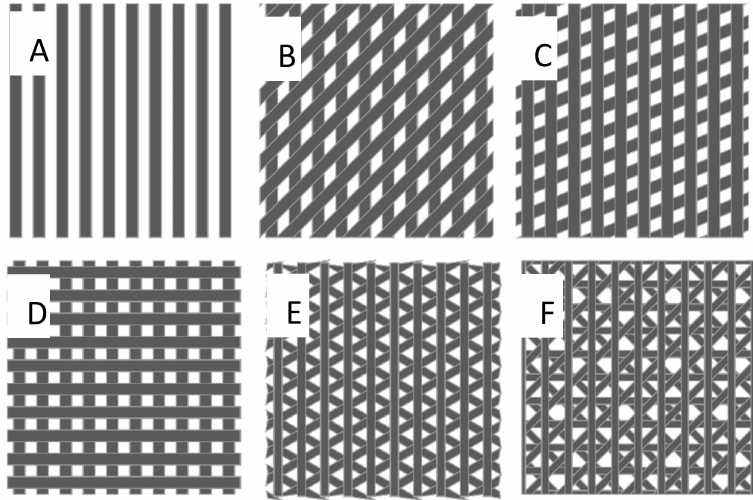
Figure 2. The six structure types. Linear ( A ), onefold crossed at angles of 45 ◦ ( B ), 67.5 ◦ ( C ), and 90 ◦ ( D ), twofold crossed ( E ) with crossing angles of 60 ◦ and 120 ◦ , threefold crossed ( F ) at 45 ◦ , 90 ◦ and 135 ◦ .